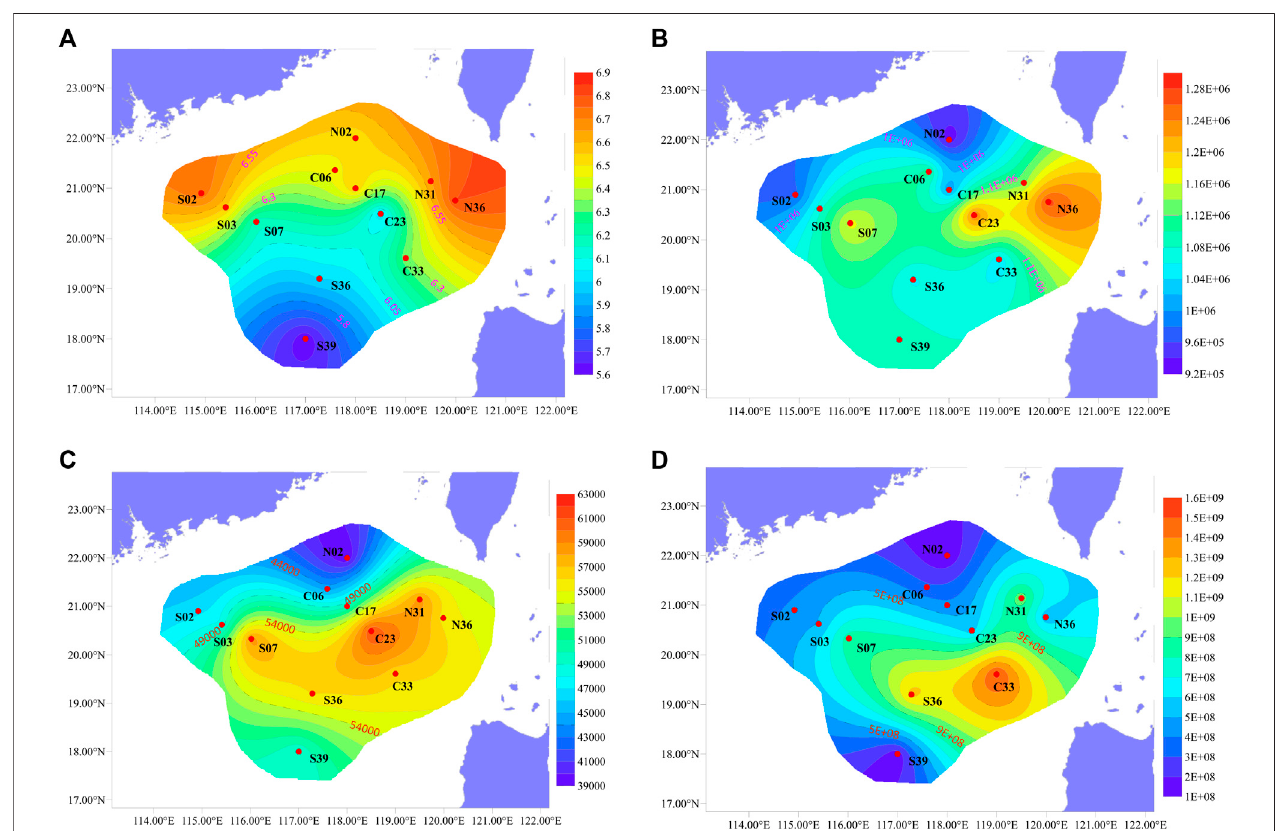
FIGURE 4 | Regional distribution of (A) Shannon index, (B) Xenobiotics Biodegradation and Metabolism (at second level), (C) Metabolism of xenobiotics by cytochrome P450 (at third level), (D) 16S gene.